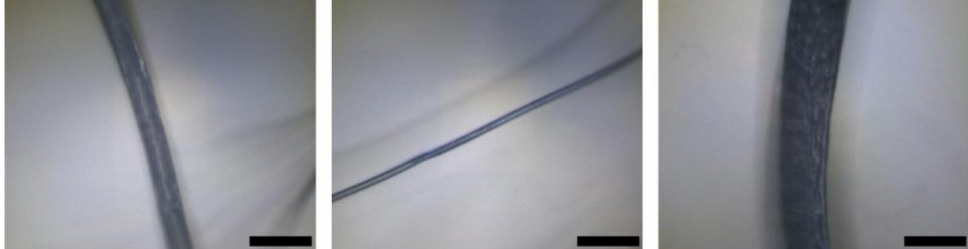
Figure 7. Images of representative synthetic fibers analyzed by FTIR